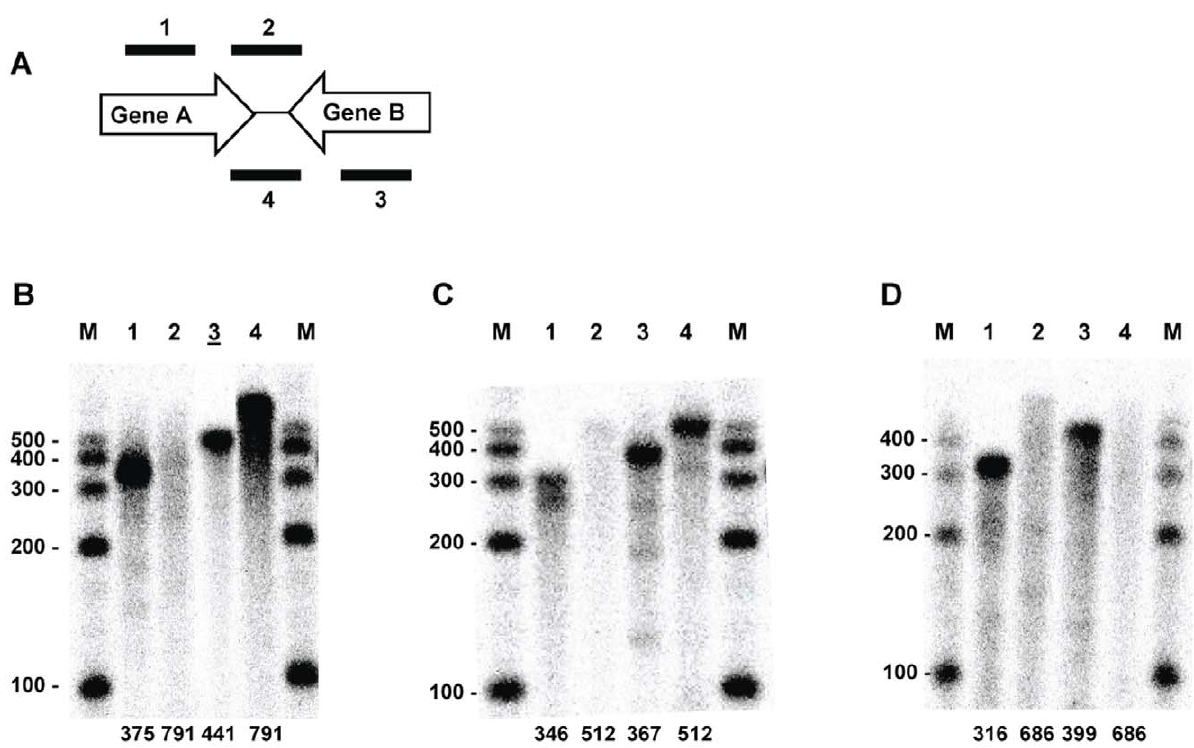
Figure 1. RPA analysis identifying transcripts of three convergent gene pairs that exhibit non-site-specific termination. (A) Schematic indicating the relative positions of the RPA probes for each convergent gene pair (Tables 1 and 2). The probes include two internal probes to confirm gene transcription and two intervening probes of opposite orientation to detect intergenic mRNA. Probes 1 and 2 hybridize to Gene A (left) transcripts while probes 3 and 4 hybridize to Gene B (right) transcripts. (B) RP145-RP146. (C) RP495-RP496. (D) RP777-RP778. Lane numbers correspond to the probe numbers in the schematic. Numbers at the bottom of each lane correspond to the size of the probe in bases. M, sized markers with sizes (in bases) indicated. Lane B3 (underlined) was digitally moved horizontally using Microsoft Office PowerPoint to maintain consistent lane organization.